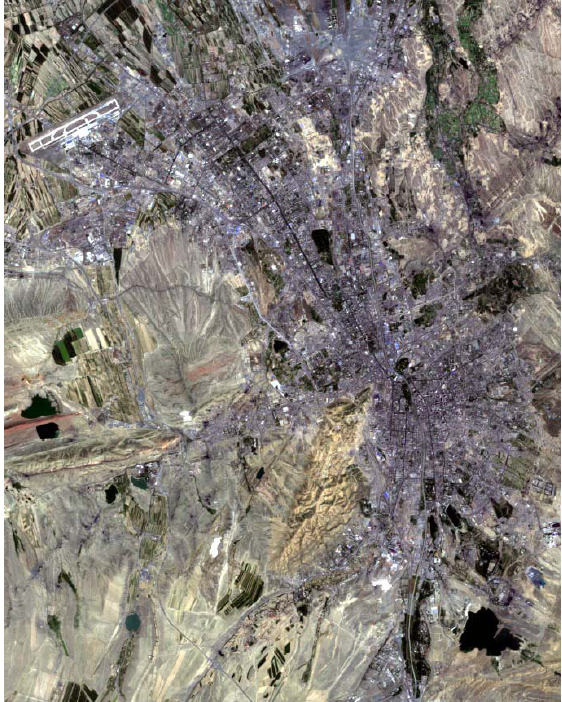
Figure 1 Landsat ETM image for Urmqi.